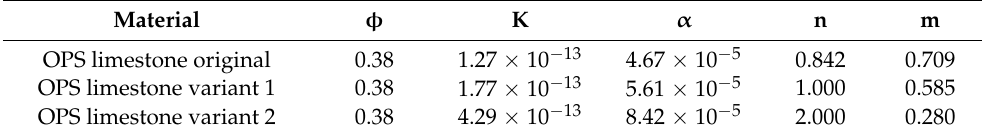
Table 1. Parameter values for the original OPS limestone from [1] and two variations on this